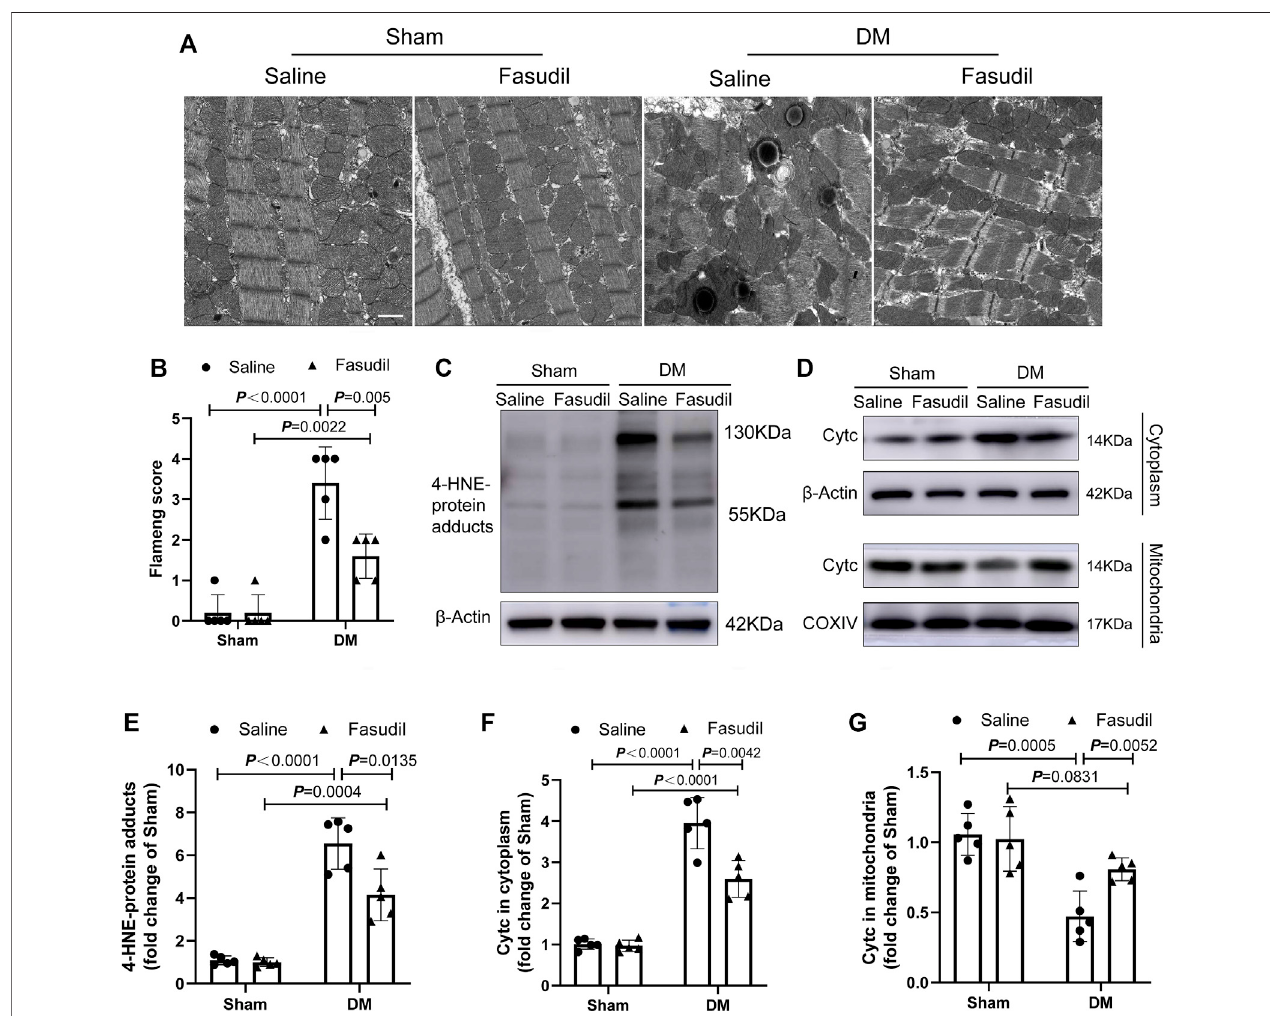
FIGURE 4 | Fasudil reduced mitochondrial dysfunction in the heart of diabetic mice (A,B) Representative sections and quanti fi cation of mitochondrial morphology by TEM of mouse hearts (n = 5). Scale bar = 1 μ m (C,E) Immunoblotting and the relative quantitative assessment of 4-HNE-protein adducts levels (n = 5) (D,F,G) Representative immunoblots and quanti fi cation of cytoplasmic Cytc protein levels and mitochondrial Cytc levels (n = 5). p -values were adjusted for comparisons of multiple means.